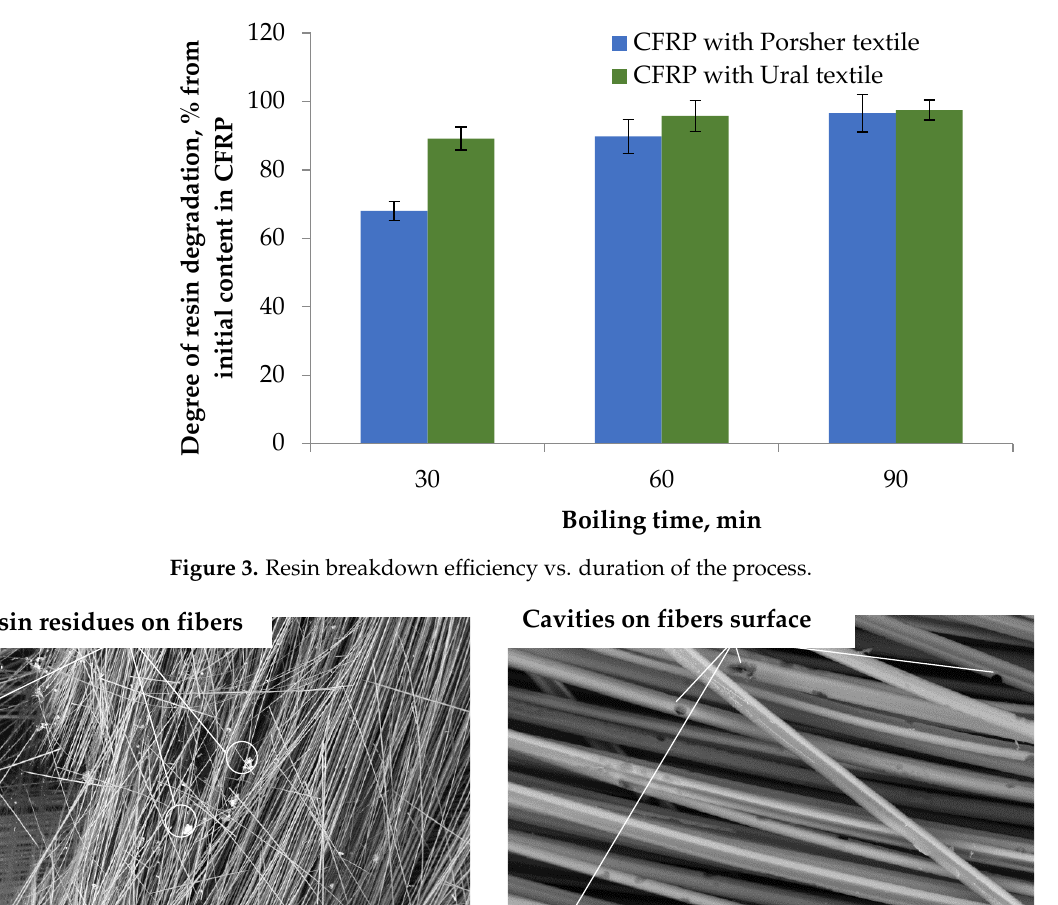
Figure 2. The result of processing CFRP by the solvolysis method: CFRP before the process ( a ) with Ural fabric and ( c ) with Porsher fabric; ( b , d ) recovered fibers after solvolysis at the second stage.